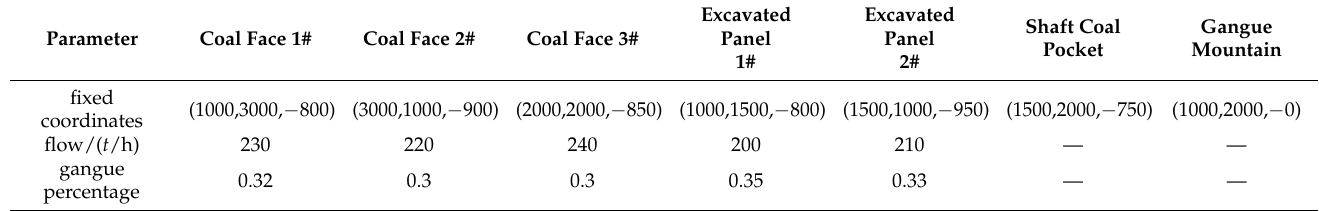
Table 2. Input parameters.